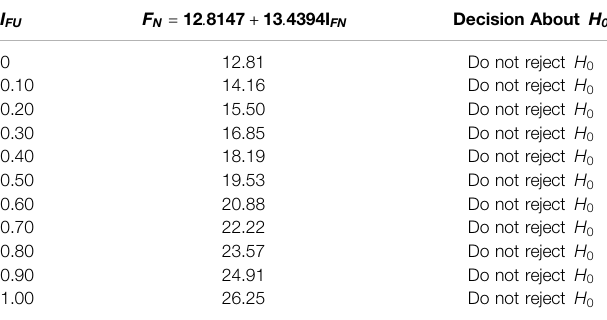
TABLE 1 | The effect of indeterminacy on F N ε [ F L , F U ] . F N (cid:1) 12 . 8147 + 13 . 4394I